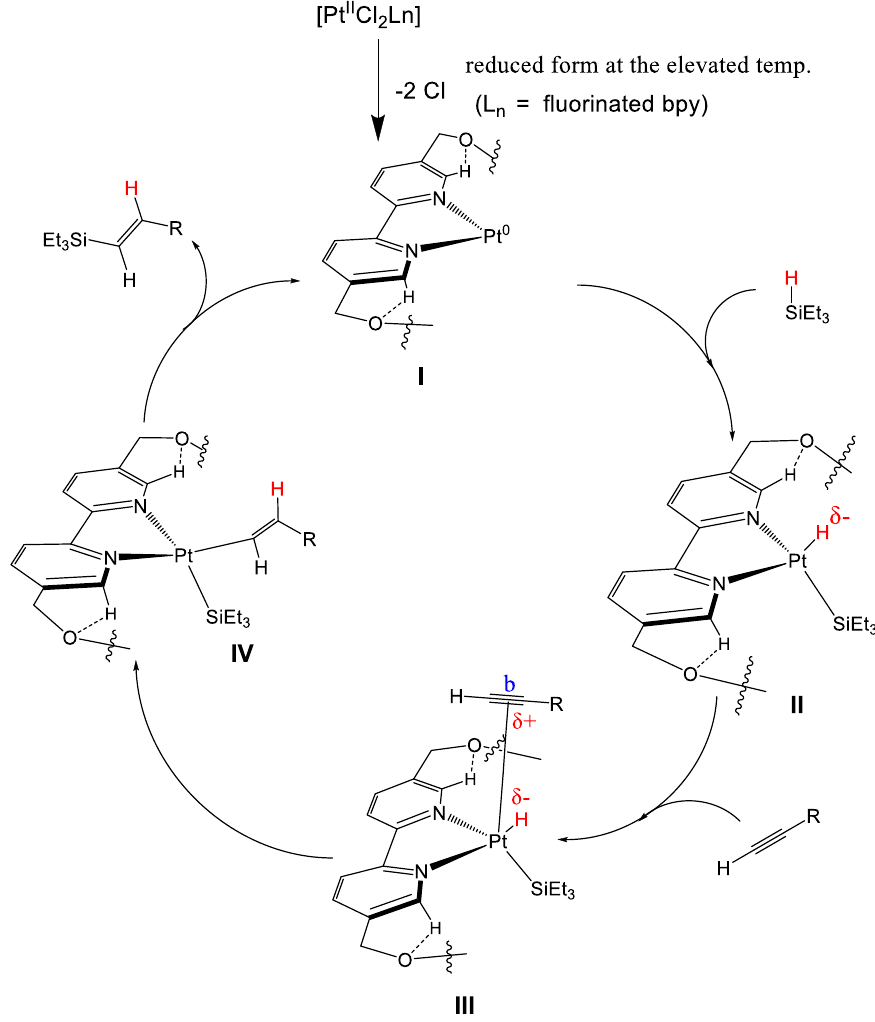
Figure 1. The proposed mechanism for 2A -catalyzed hydrosilylation of terminal (alkyl) alkyne with triethylsilane . (Note: H is labeled in red color).